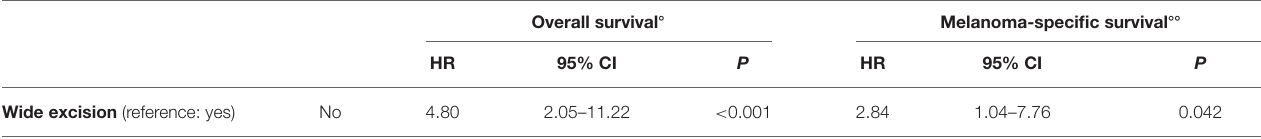
TABLE 3 | Cox regression model for overall and melanoma-specific survival (HR, hazard